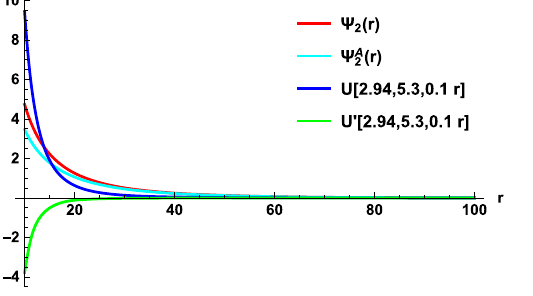
( r ) < 0. (Right) Far- aadR ( r ) with con- 2